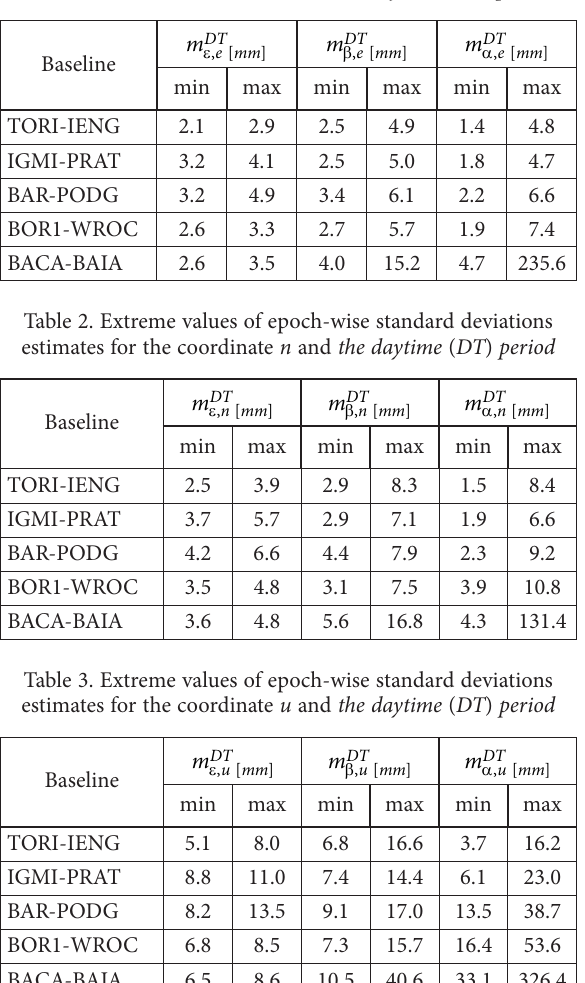
Table 4. Extreme values of epoch-wise standard deviations estimates for the coordinate e and the nighttime ( NT ) period